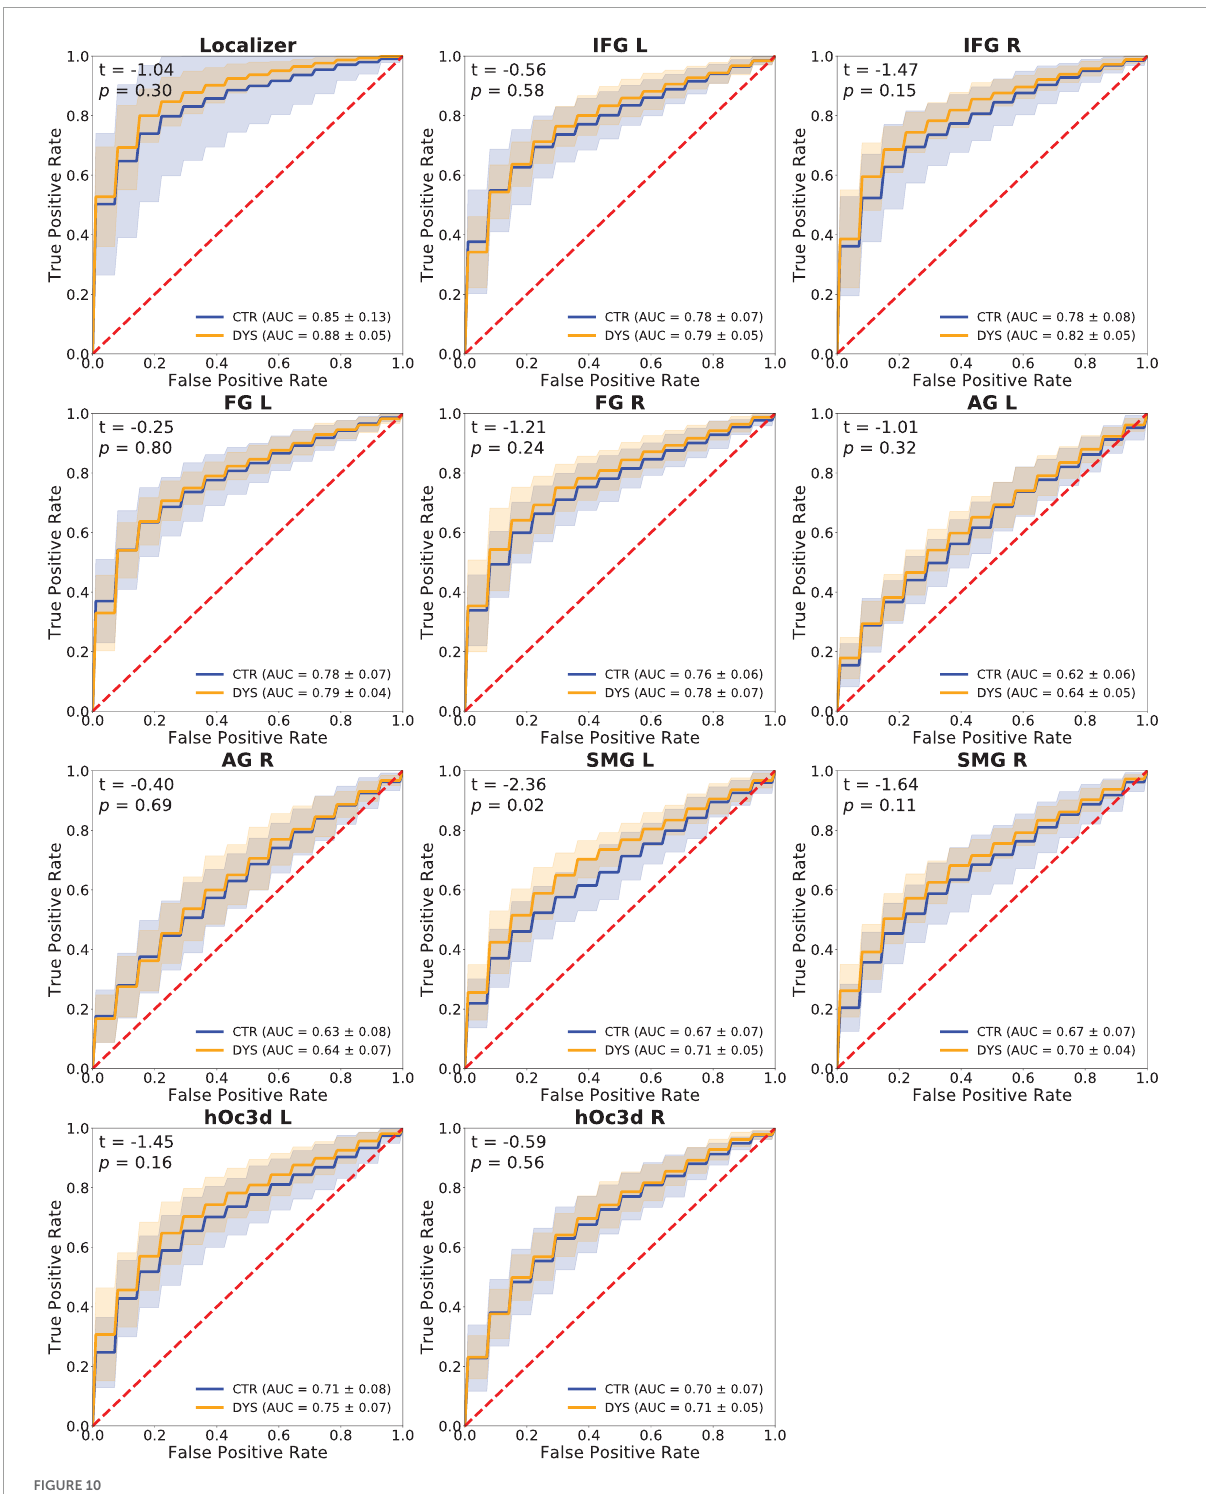
FIGURE10 Classification performance (ROC curves) of a Support Vector Machine classifier in each ROI. The mean ROC scores of the two groups are shown in the bottom right corner, t -values and p -values of a two-sample t -test are shown in the upper left corner, the shaded areas correspond to ± 1 SD of the ROC curve. DYS: dyslexic readers, CTR: typical readers, IFG: inferior frontal gyrus, FG: fusiform gyrus, AG: angular gyrus, SMG: supramarginal gyrus, hOc3d: Dorsal extrastriate cortex, L: left hemisphere, R: right